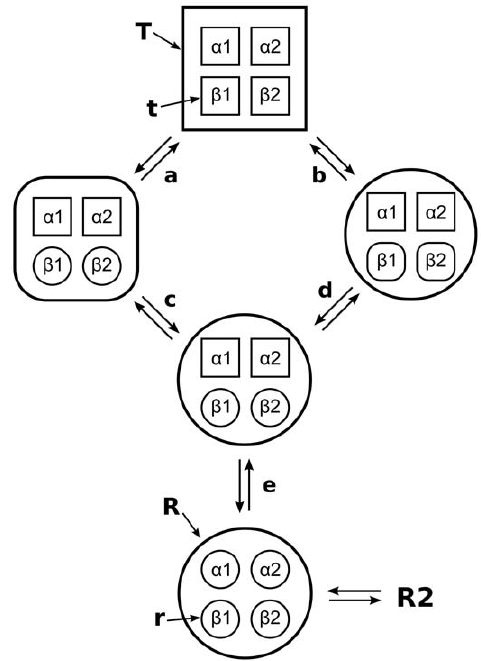
Figure 8. Schematic representation of consensus transition pathways between the R and T state as derived from the MD simulations. The large sphere and square depict the quaternary R and T states, respectively, whereas the small spheres and squares depict tertiary r and t states, respectively. A square with round corners indicates an intermediate structure between R and T or between r and t .